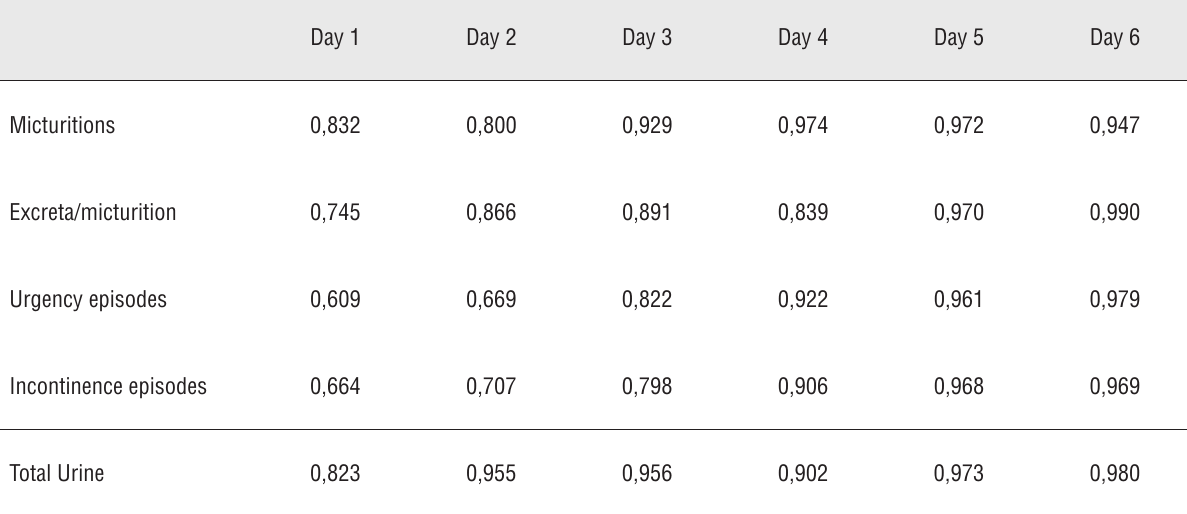
Table 2 - Correlations of different diary’s length with the 7-day duration diary for the evaluated parameters (r values).